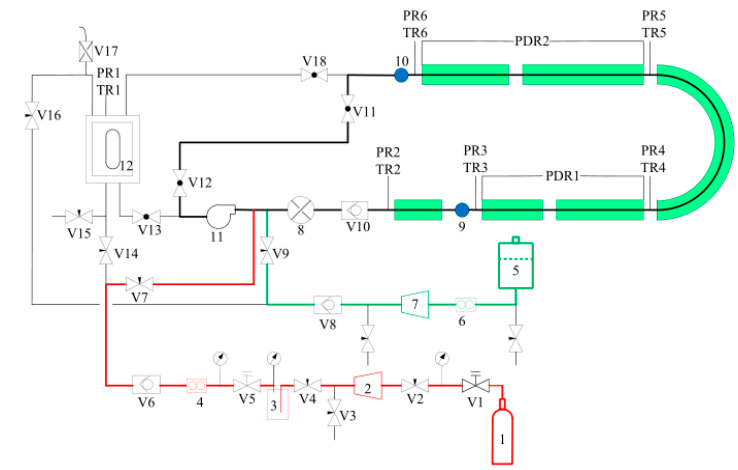
Figure 2. Schematic diagram of the High-pressure flow loop: 1—gas cylinder; 2—gas booster pump;